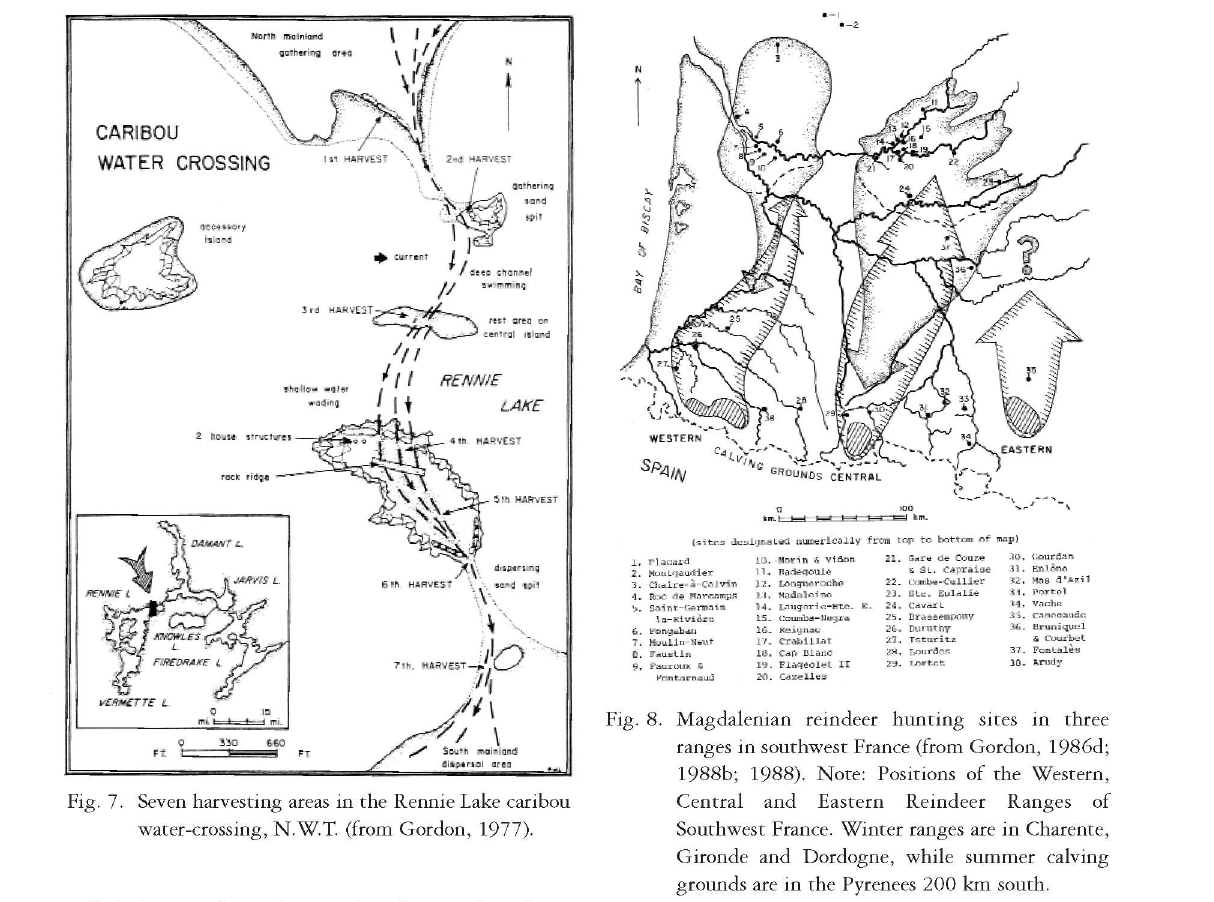
Fig. 7. Seven harvesting areas in the Rennie Lake caribou water-crossing, N.W.T. (from Gordon, 1977).